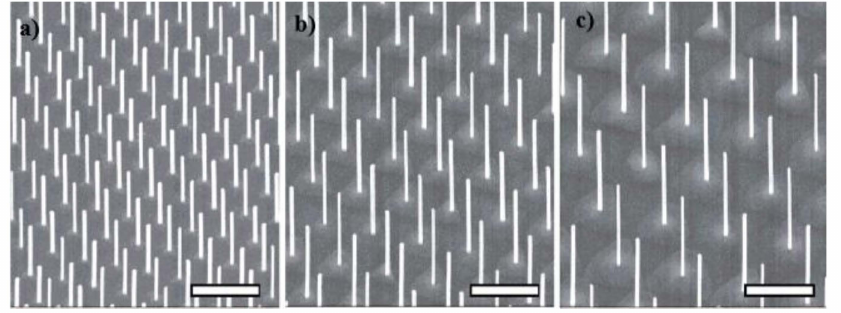
Figure 3. SEM tilted views of nanowire InAs NW arrays grown from EBLprepatterned substrates. The NWs have same diameters but different inter-wire distances: ( a ) 0.5 µ m, ( b ) 0.75 µ m and ( c ) 1 µ m. The nanowires were grown from Au catalysts realized by electron beam lithography. Scale bar is 1 µ m in each panel. (Reprinted with permission of Ref.